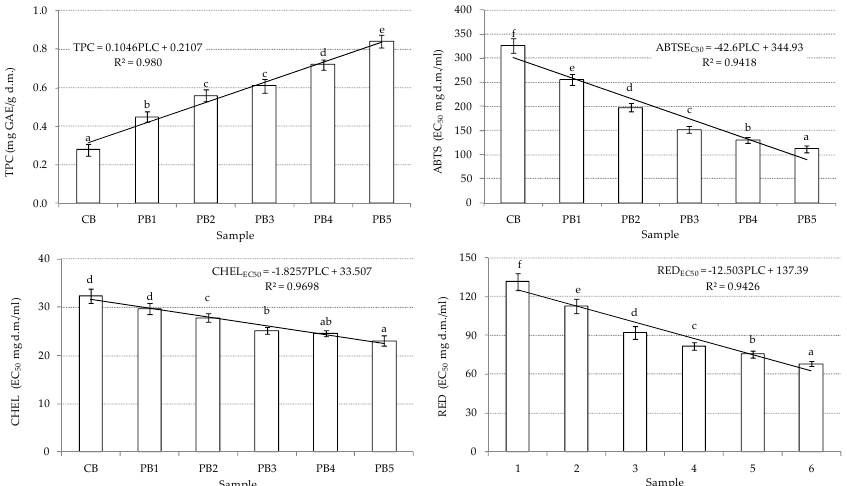
Figure 4. The total phenolic content and antioxidant activity of the control and enriched bread. TPC—total phenolic content; ABTS—ABTS-neutralizing activity; CHEL—chelating power; RED—ferric reducing power; CB—control bread; PB1, PB2, PB3, PB4, and PB5—bread with 1, 2, 3, 4, and 5% of parsley. PLC—content of parsley leaves (%) Different letters on the bars (a–f) denote significant differences